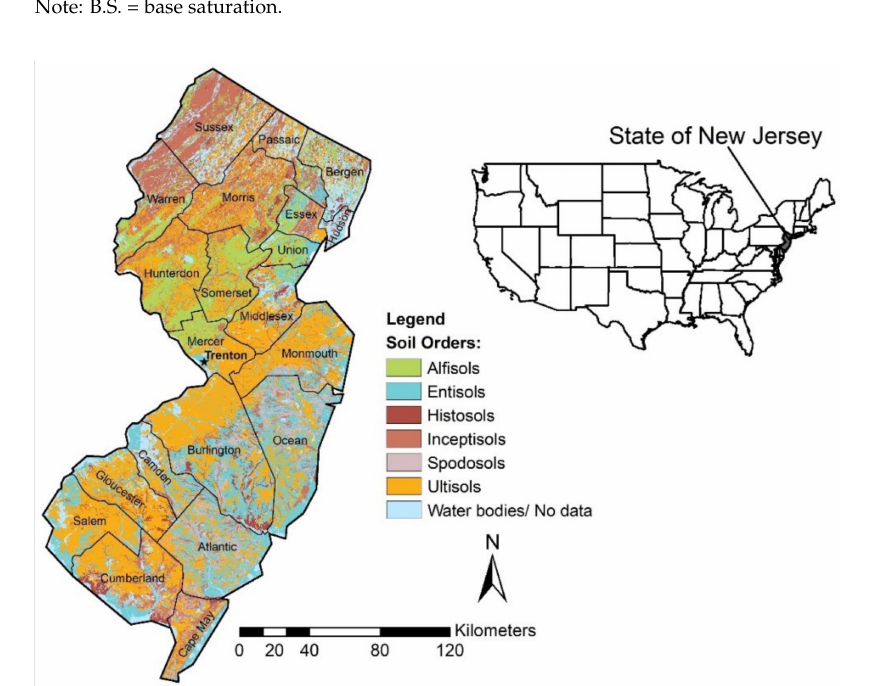
Figure 2. General soil map of New Jersey (USA) (Latitude: 38 ◦ 56 (cid:48) N to 41 ◦ 21 (cid:48) N; Longitude: 73 ◦ 54 (cid:48) W to 75 ◦ 34 (cid:48) W) from the SSURGO database [12] with county boundaries overlaid